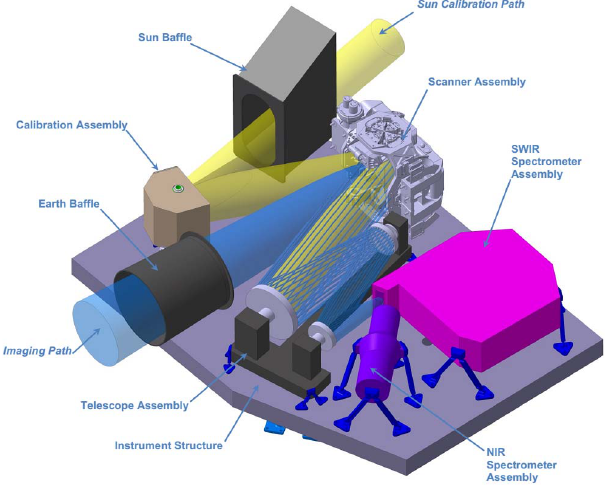
Figure 2. Sketch of the G3E instrument. Sunlight backscattered by the Earth enters the instrument through the “Earth Baffle” from the lower left into the telescope consisting of the “Scanner Assembly” and several mirrors that direct the incoming light into beam split- ting optics (not visible) feeding the four spectrometers. The three SWIR spectrometers share a housing. For calibration purposes, the Scanner Assembly is able to point toward the “Calibration Assem- bly” which either operates calibration lamps or LEDs (light emitting diodes) or collects direct sunlight through the “Sun Baffle”. The dimensions of the instrument are roughly 1600 × 1300 × 800mm (length × width × height).